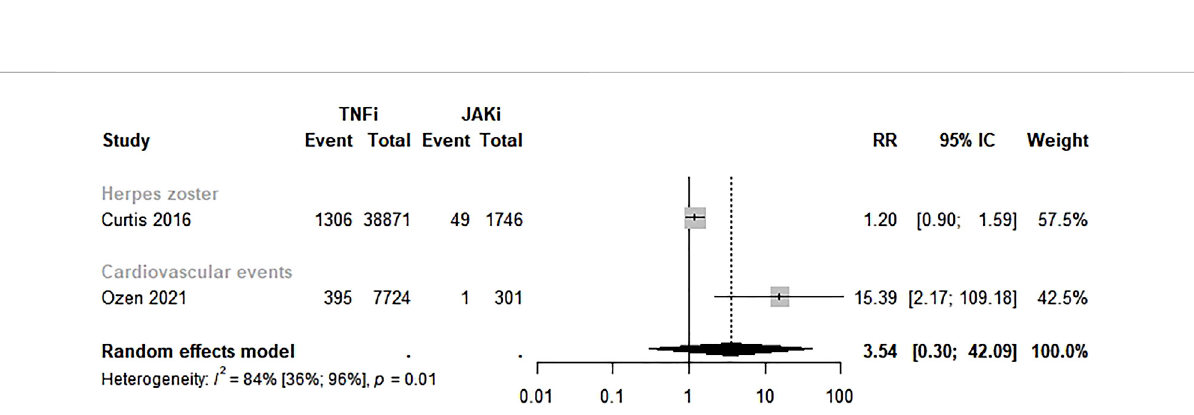
FIGURE 6 Comparative safety of TNF inhibitors and JAK inhibitors. TNFi: TNF inhibitors; JAKi: Janus Kinase